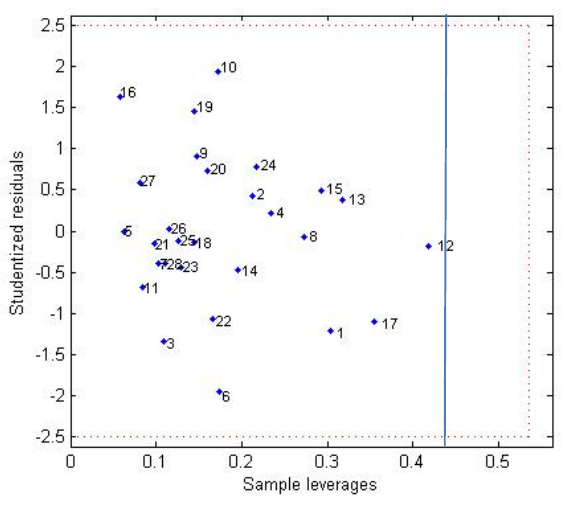
Figure 3. William’s plot.